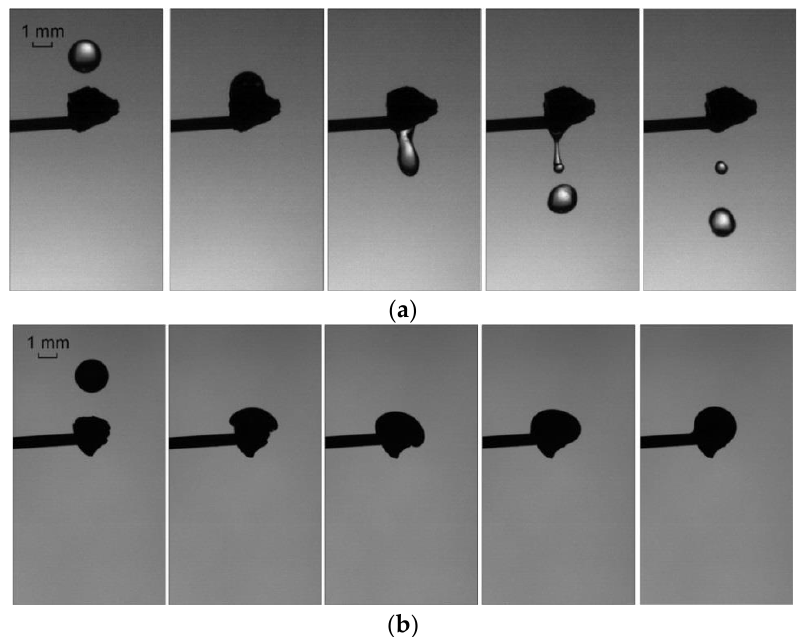
Figure 4. Images of the interaction of liquid droplets with carbonaceous particles of coking coal filter cake at Δ = 2: ( a ) — water; ( b ) — used motor oil.